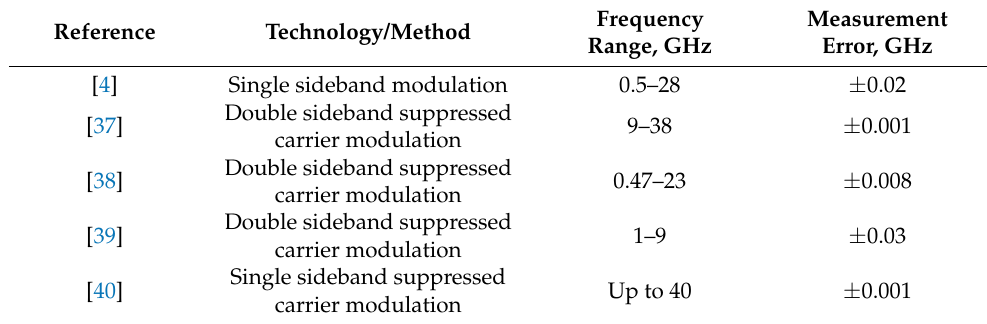
Table 5. Performance of IFM techniques based on